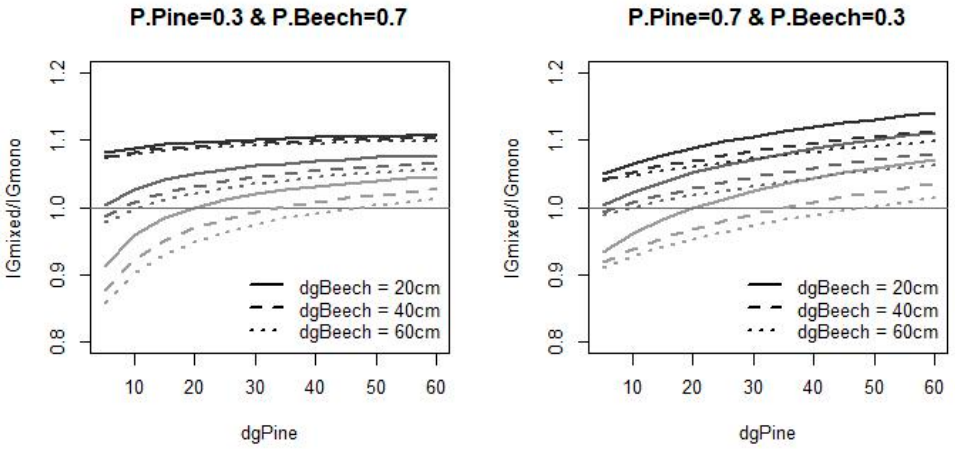
Figure 6. Influence of differences in species diameter on the total basal area growth ratios between total mixed and monospecific stands (IGmixed/IGmono). Dominant height H o = 20 m and relative density RD = 0.6. Light grey lines for Martonne aridity index M = 30, medium grey lines M = 60, and dark grey lines M = 90 mm/ ◦ C. P. Pine and P. Beech represent pine and beech proportion